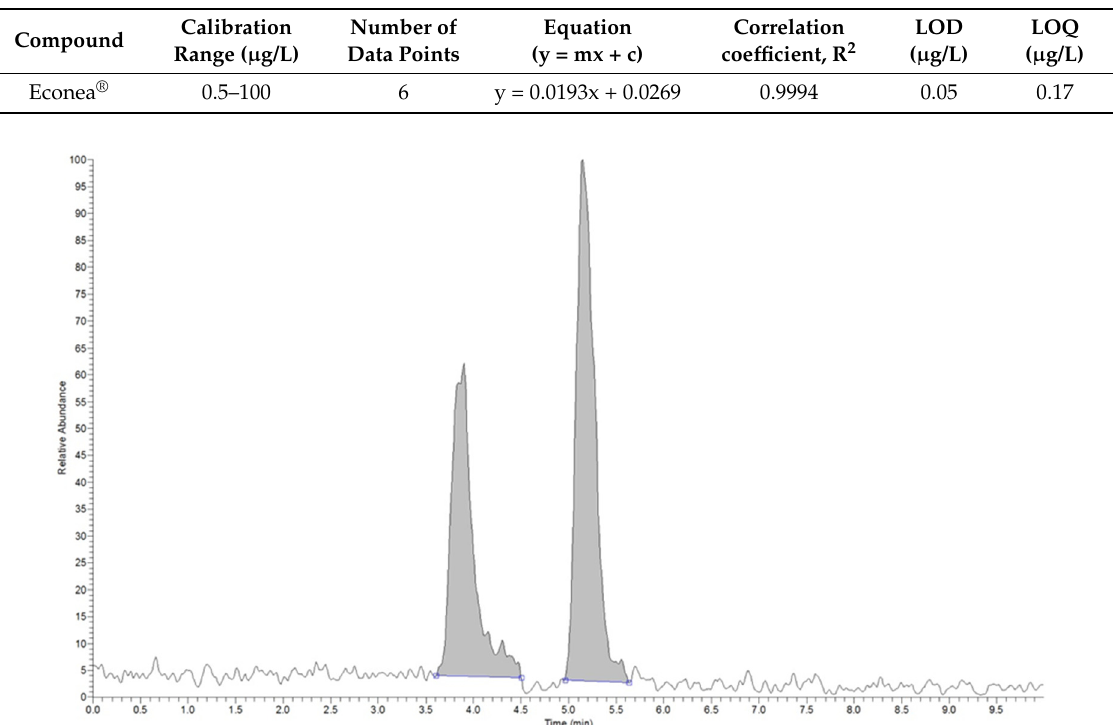
Figure 1. Example chromatogram of sample containing 50 μ g/L internal standard (Tr = 3.95 min) and 50 μ g/L Econea ® (Tr = 5.25 min).